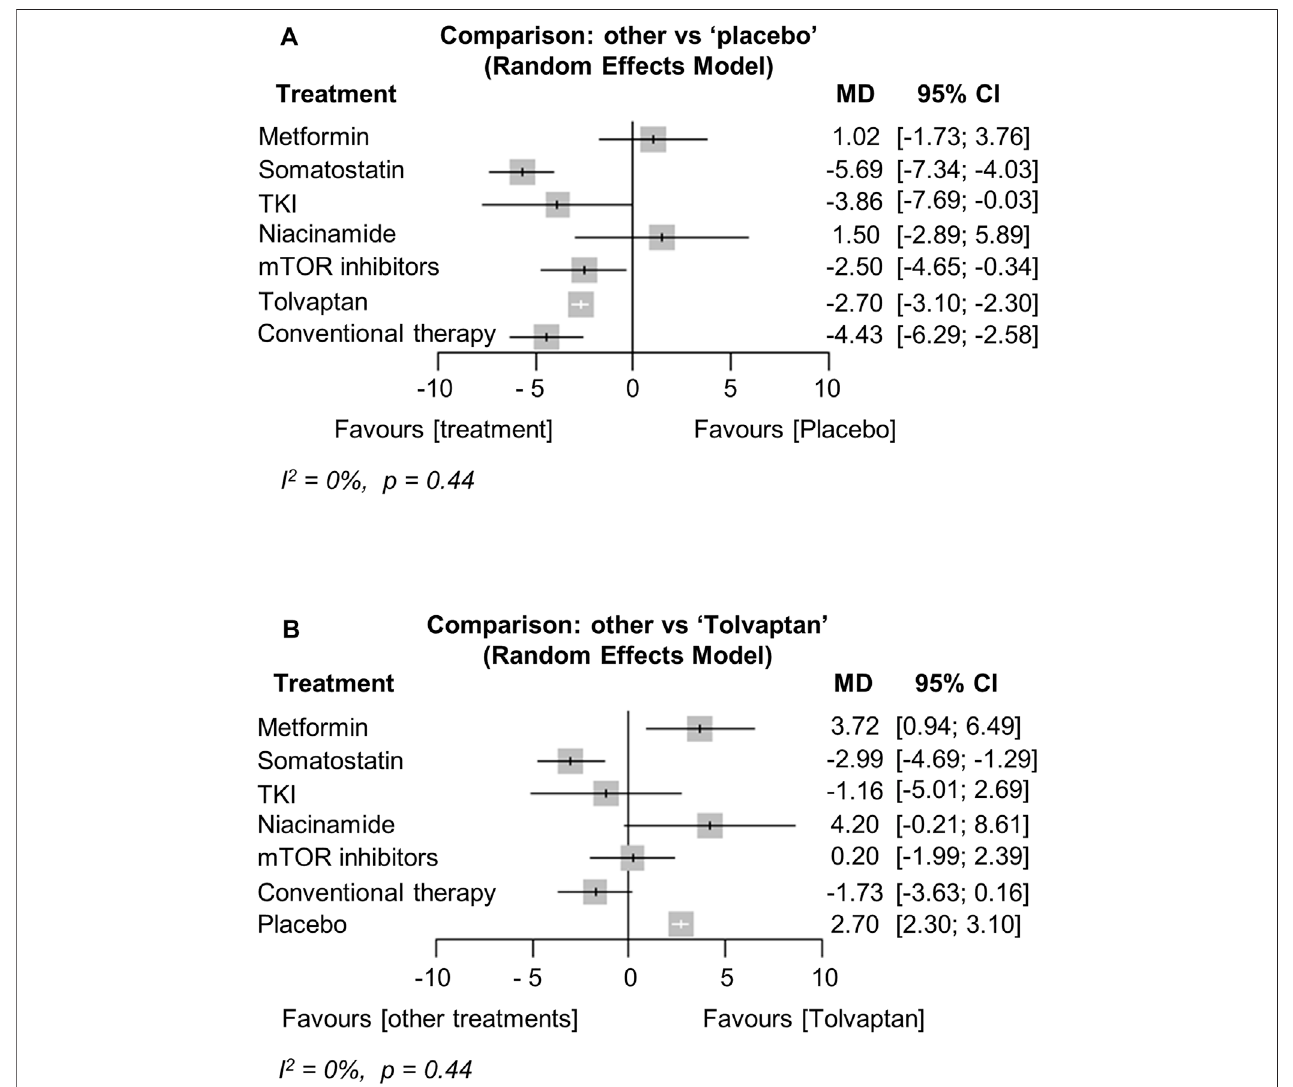
FIGURE3| Networkmeta-analysisreportingthemeandifference(MD)foreachtreatmenteffectofinhibitingtotalkidneyvolume(TKV)growthratecomparedto (A) the placebo and (B) tolvaptan in ADPKD patients. CI, con fi dence interval; TKI, tyrosine kinase inhibitor; ADPKD, autosomal dominant polycystic kidney disease.